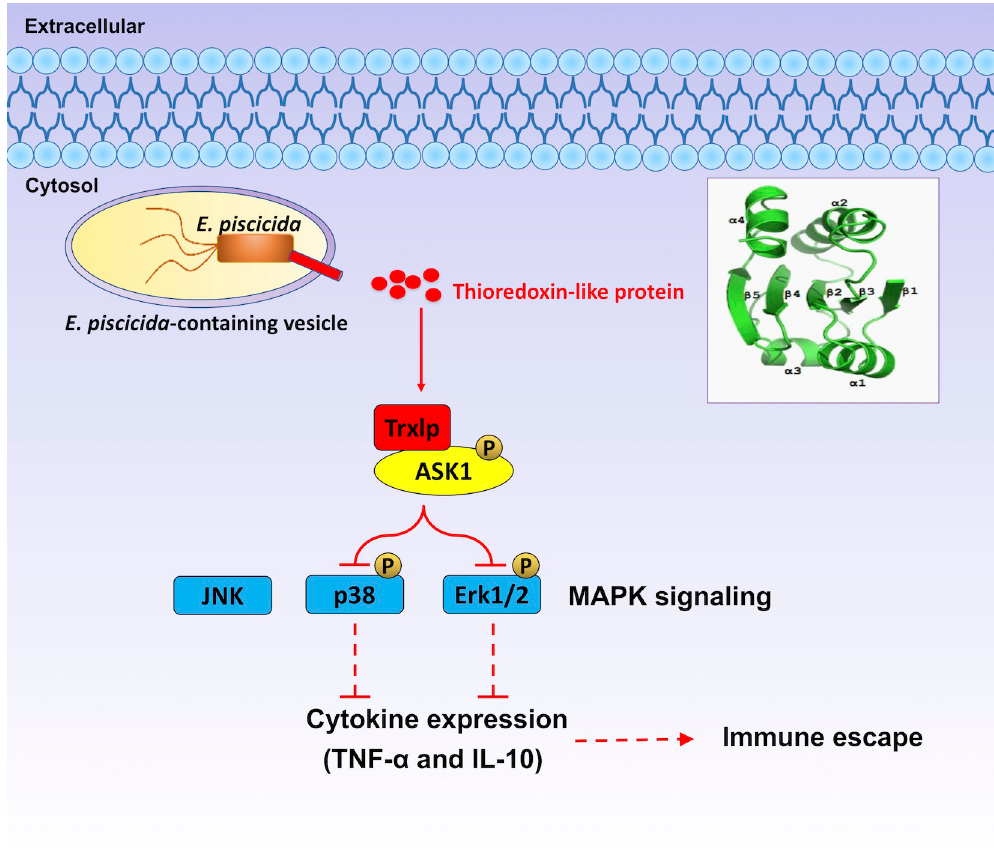
Fig 6. Proposed mechanism for E . piscicida thioredoxin-like protein. The novel bacterial virulence effector, thioredoxin- like protein (Trxlp), could be translocated into cytosol of host cells, mimicking the endogenous TRX1 to target ASK1-MAPK signaling to restrict the innate immune response in vivo